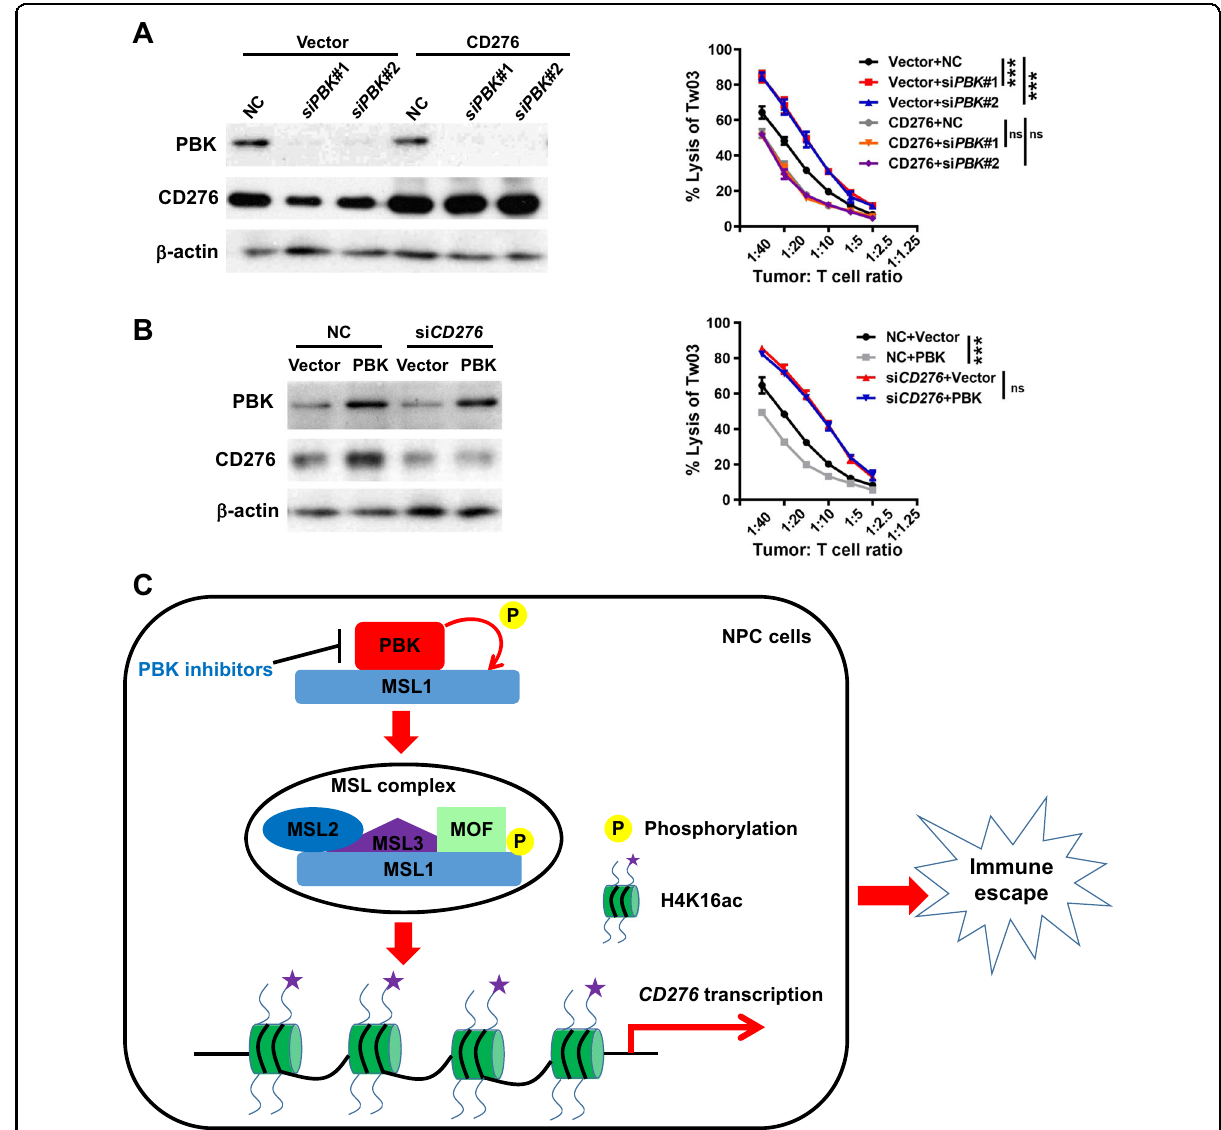
Fig. 6 PBK modulates the T-cell-mediated killing in NPC cells mediated by CD276 in vitro. A TW03 cells were infected by lentiviruses carrying CD276 coding region to establish the CD276-overexpression (OE) stable cell lines. Control and CD276-OE cells were transfected with two PBK siRNAs or NC (nonspeci fi c siRNA) for 48 h. Then, the prepared tumor cells and activated T cells were cocultured at a ratio of 1:40 – 1:1.25 (tumor cells:T cells) in triplicates and the cytolysis of tumor cells was evaluated using the xCELLingence real-time cell analysis (RCTA) system. Left, immunoblotting analysis using indicated antibodies. Right, the cure displayed the percentage of lysis tumor cells at a ratio of 1:40 – 1:1.25 (tumor cells:T cells). Data shown are mean ± SD and the P values were calculated by one-way ANOVA. *** P < 0.01, ns (not signi fi cant) means P > 0.05. B TW03 cells were infected by lentiviruses carrying PBK coding region to establish the PBK-overexpression (OE) stable cell lines. Control and PBK-OE cells were transfected with one CD276 siRNA or NC (nonspeci fi c siRNA) for 48 h. Then, the cytotoxic T-lymphocyte assay was performed as mentioned above. Left, immunoblotting analysis using indicated antibodies. Right, the data shown are mean ± SD and the P values were calculated by Student ’ s t test (two-tailed). *** P < 0.01, ns (not signi fi cant) means P > 0.05. All the experiments were performed independently three times with similar results and the data are representative of three independent experiments. C Proposed model of the PBK/MSL1/CD276 signaling pathway that regulates immune invasion in NPC cells, as well as the intervention